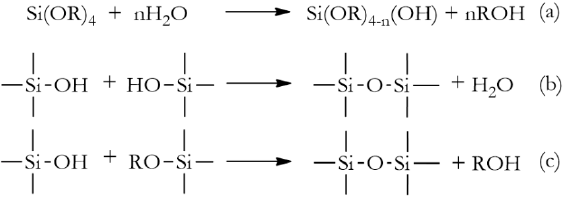
Figure 6. Schematic representation of an alkoxysilane’s hydrolysis ( a ); hydrolytic condensation ( b ) and alcohol condensation ( c ) steps.